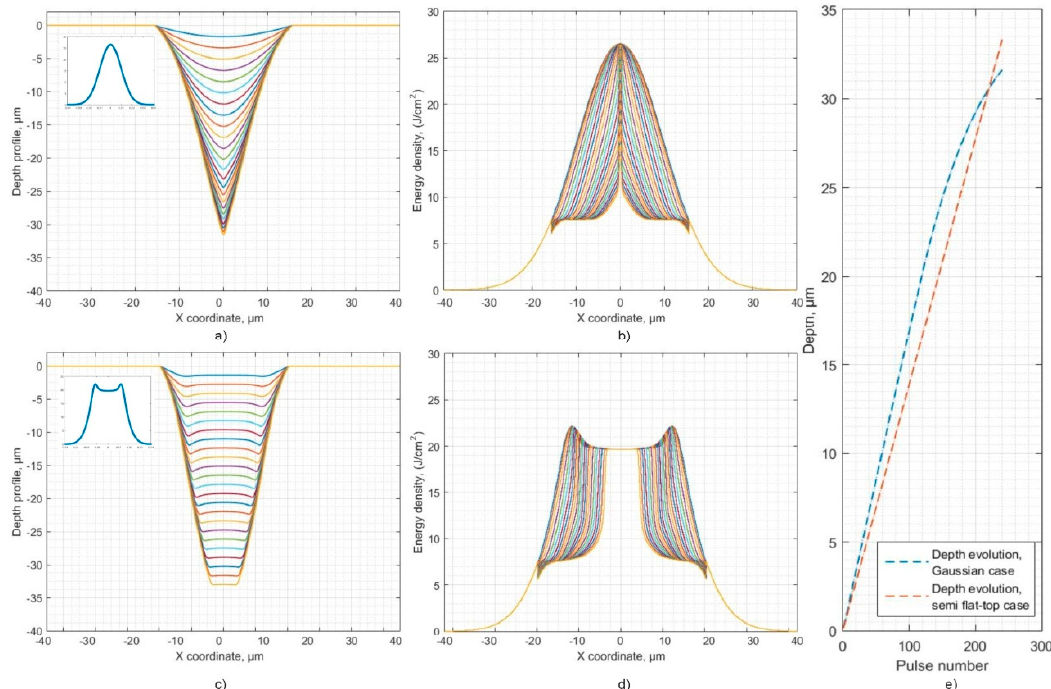
Figure 6. The numerical evolution of the crater profiles while multiple pulses impinge on the surface. ( a ), 240 pulses impinge on the surface (Gaussian (top left inset) intensity distribution), ( b ) the evolution of the energy density due to the change in the surface area. ( c ), 240 pulses impinge on the surface (semi flat-top shape intensity distribution) and the total energy is 25% lower as compared with the Gaussian case, ( d ) , the evolution of the energy density. ( e ) The depth is plotted against the number of pulses for the two cases. The individual lines show the shape after multiples of 10 pulses.